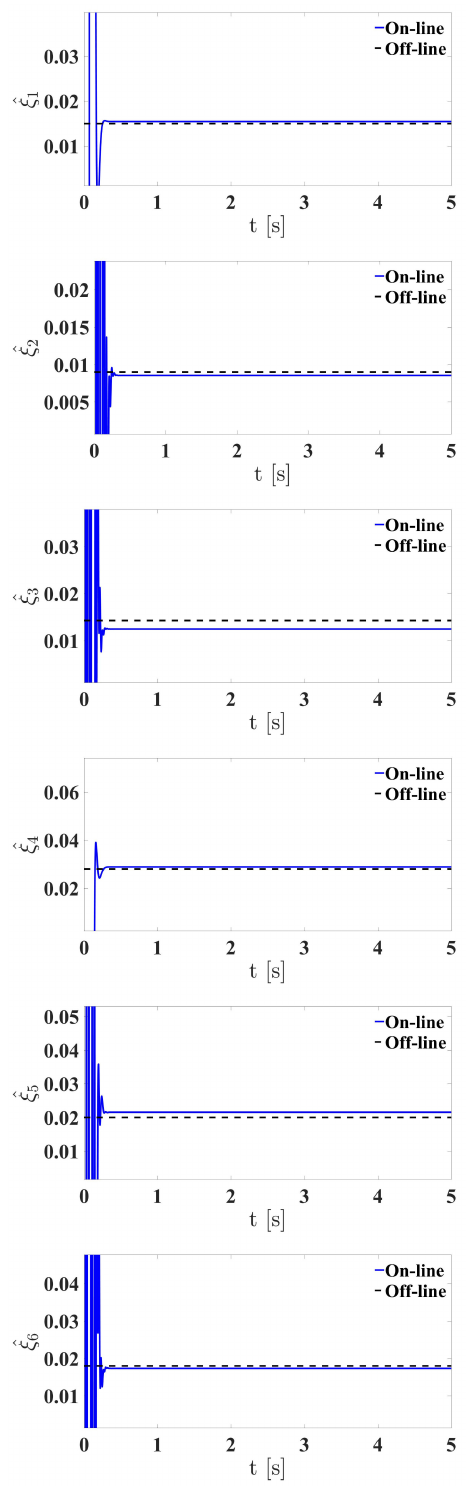
Figure 16. Algebraic and on-line estimation of damping